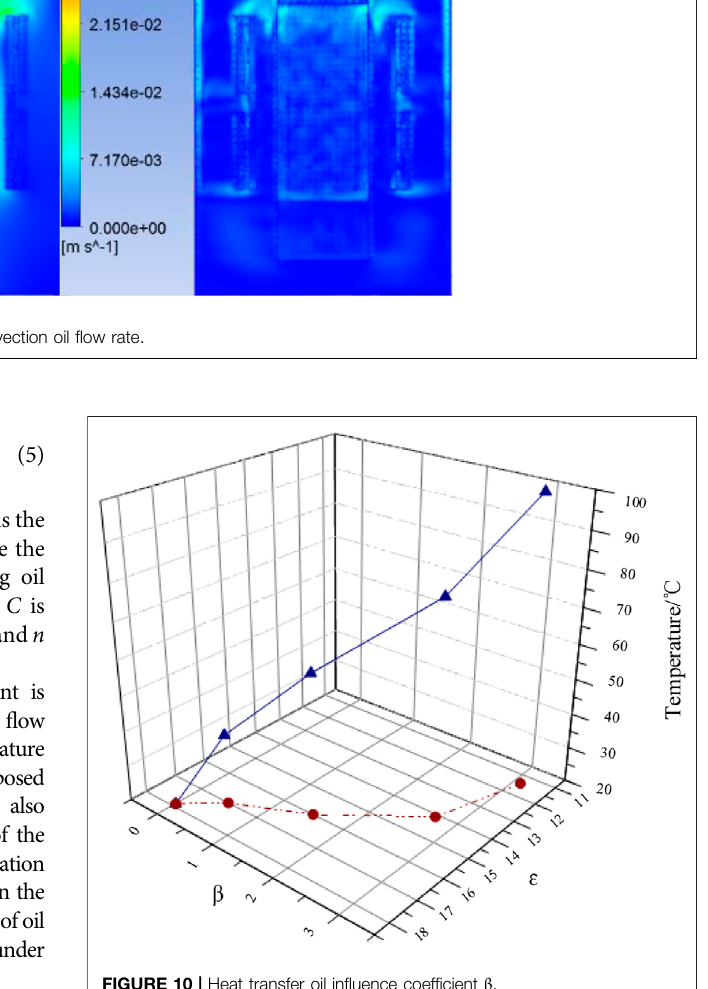
FIGURE 10 | Heat transfer oil in fl uence coef fi cient β